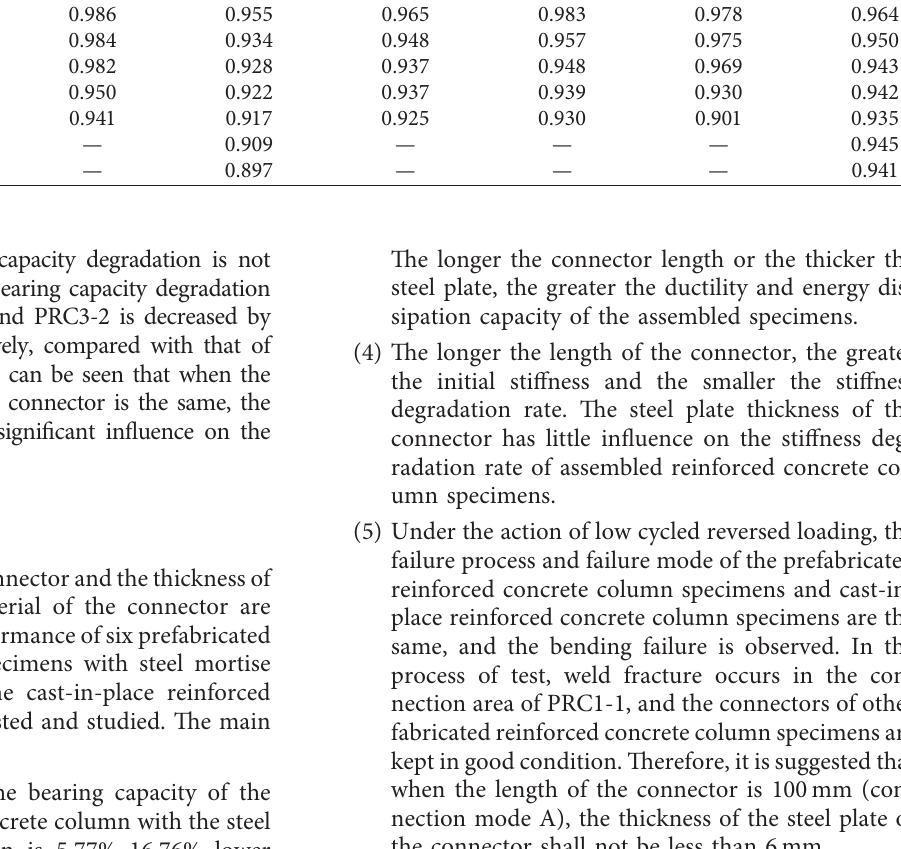
Table 6: Degradation rate of bearing capacity Φ Specimen